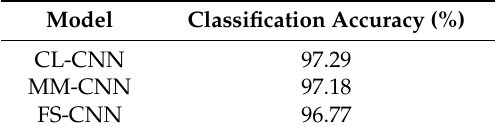
Table 4. Overall Classification Accuracy of FVs Coding Method Using Different CNN architecture.